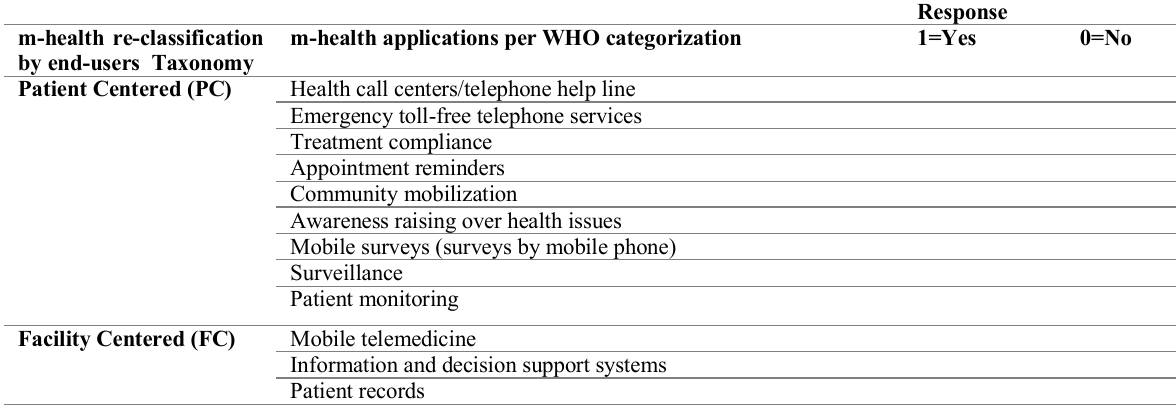
Table 1: M-health applications categories and re-categorization as per WHO